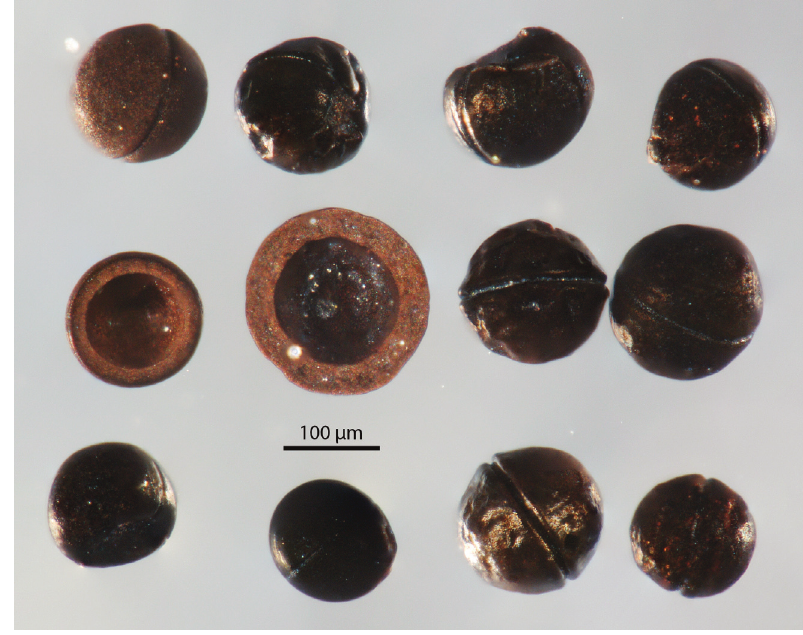
Fig. 3. Light microscopy images of Vikisphaera kundana gen. et sp. nov. from the type locality, Viki core, depth 360.9–361.1 m, sample OM8-4, Kunda Regional Stage, lower